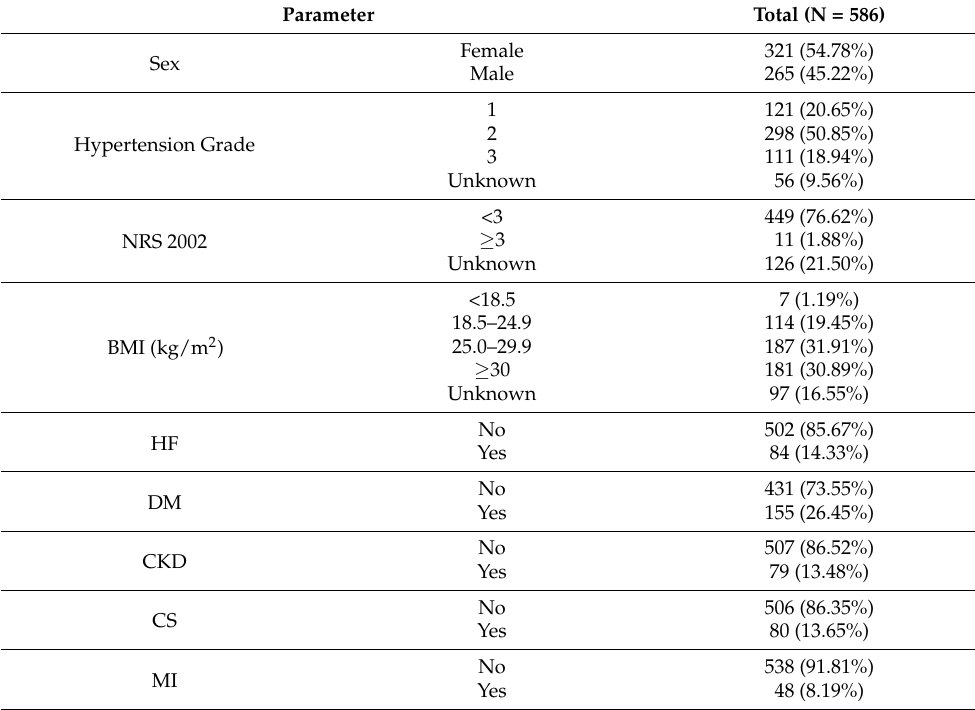
Table 1. Study group characteristics (qualitative